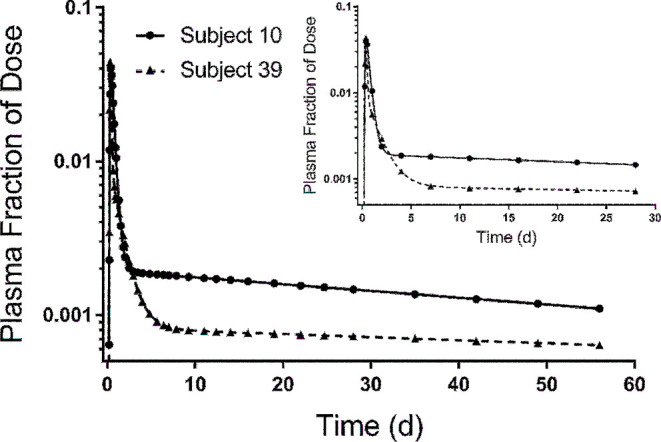
Model-simulated plasma retinol response data vs. time after ingestion of labeled retinyl acetate for 2 theoretical subjects. Shown are data for the fraction of dose simulated at all sampling times (n = 36) from 6 h to 56 d using parameters listed in Supplemental Table 1. For subject 39, we used the model (Figure 2) with both extravascular compartments (compartments 6 and 7); for subject 10, we used the model with only one compartment (compartment 6). The inset shows simulations for the same subjects using the reduced (super-child) sampling schedule (n = 11 samples collected from 6 h to 28 d).